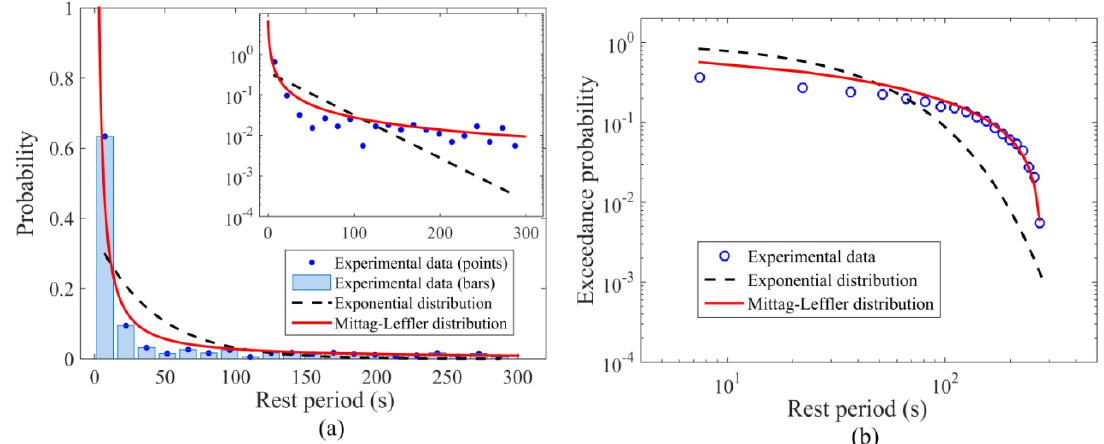
Figure 7. ( a ) Discrete probability distribution of the particle rest period ( Δ t = 0.1 s) with theoretical lines that fit the data; the inset shows the same data on a semilog plot. ( b ) Exceedance probability of the particle rest period.